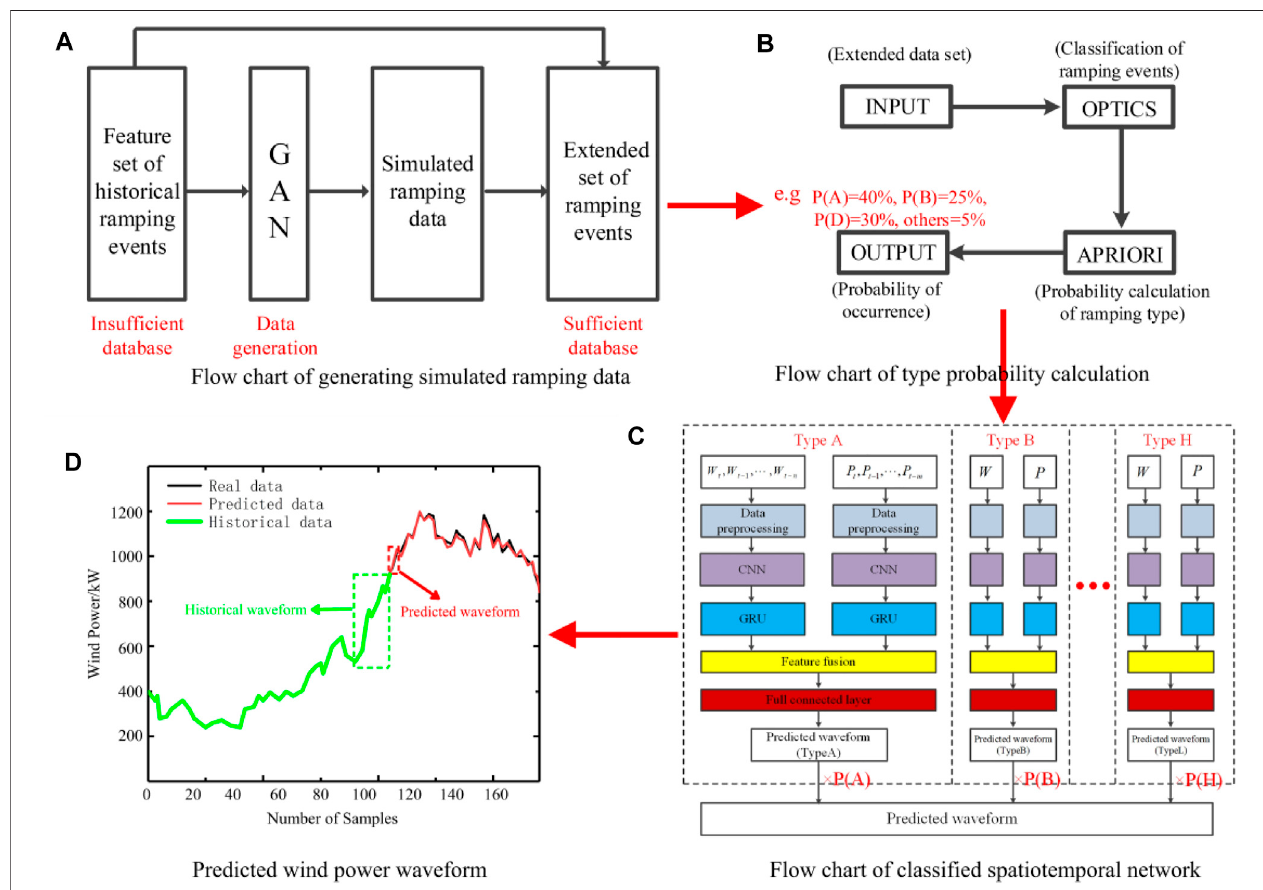
FIGURE 3 | Flow chart of the prediction model based on classi fi ed spatiotemporal network. (A) Flow chart of generating simulated ramping data, (B) Flow chart of type probability calculation, (C) Flow chart of classi fi ed spatiotemporal network, and (D) Predicted wind power waveform.